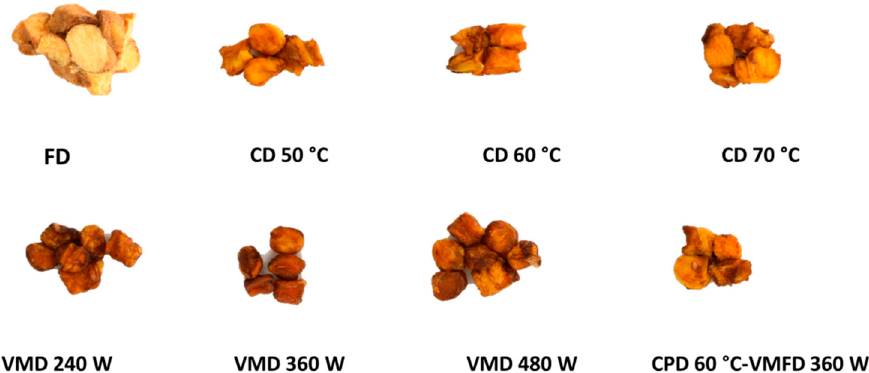
Figure 2. Dried ‘Algar’ loquat by freeze drying (FD), convective drying (CD) at 50 °C (CD 50 °C), 60 °C (CD 60 °C) and 70 °C (CD 70 °C), vacuum-microwave drying (VMD) at 240 W (VMD 240 W), 360 W (VMD 360 W) and 480 W (VMD 480 W) and combined drying (convective pre-drying followed by vacuum-microwave finish drying, CPD 60 °C-VMFD 360 W).